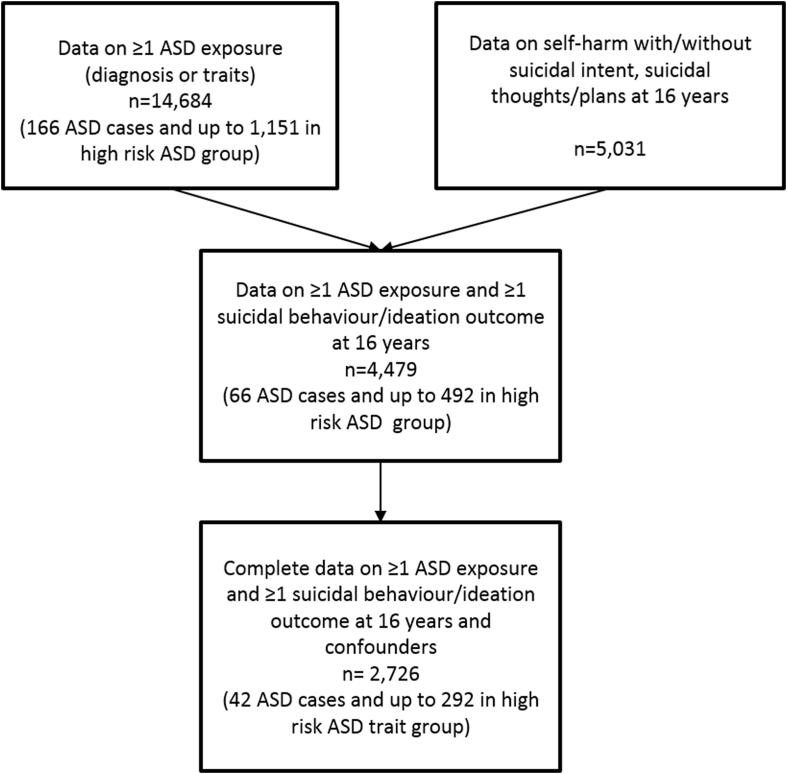
Study SampleNote:ASD = autism spectrum disorder.